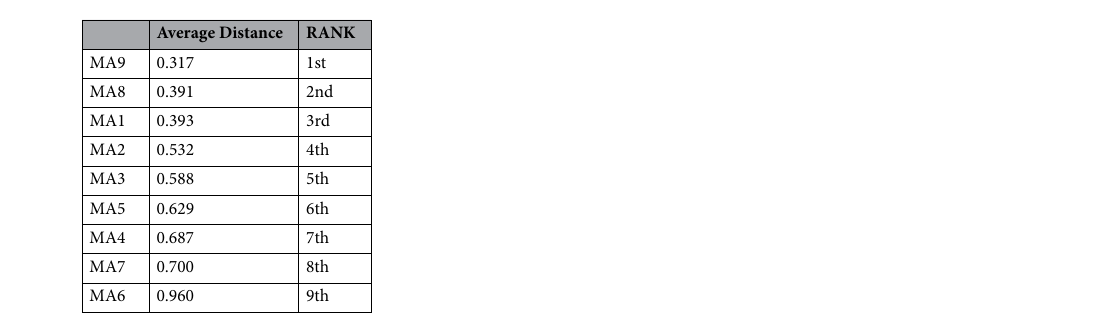
Table 4. SPOTIS average distances from the ideal